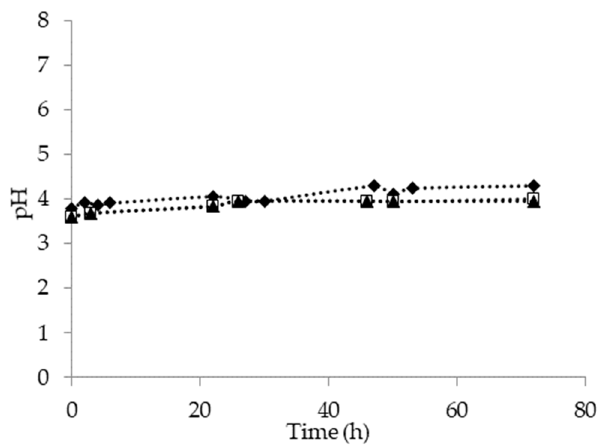
Figure 7. pH evolution during the aerobic biological treatment of pyrolysis wastewater at 15 °C (triangle), 25 °C (square) and 30 °C (rhomboid).